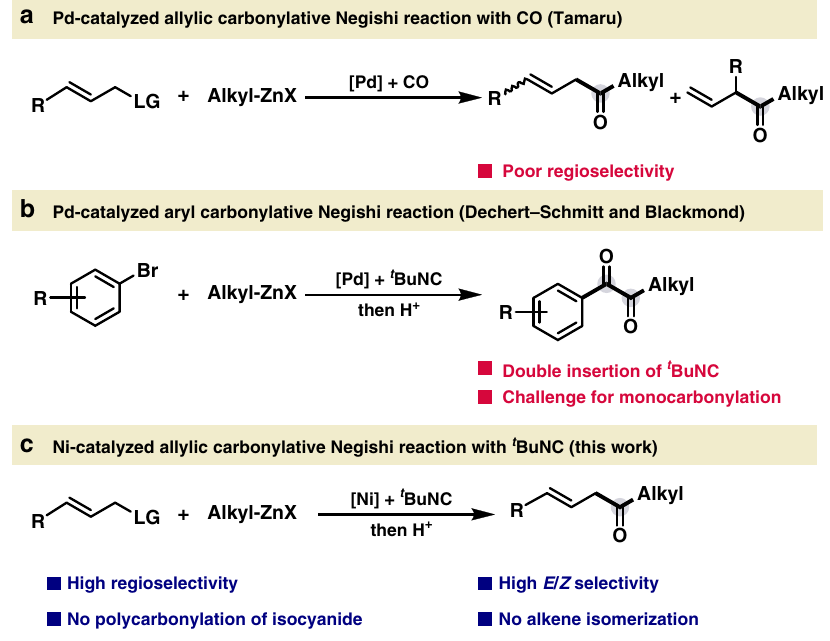
Fig. 1 Development of transition metal-catalyzed carbonylative Negishi reaction. a Pd-catalyzed allylic carbonylative Negishi reaction. b Pd-catalyzed aryl carbonylative Negishi reaction. c Ni-catalyzed allylic carbonylative Negishi